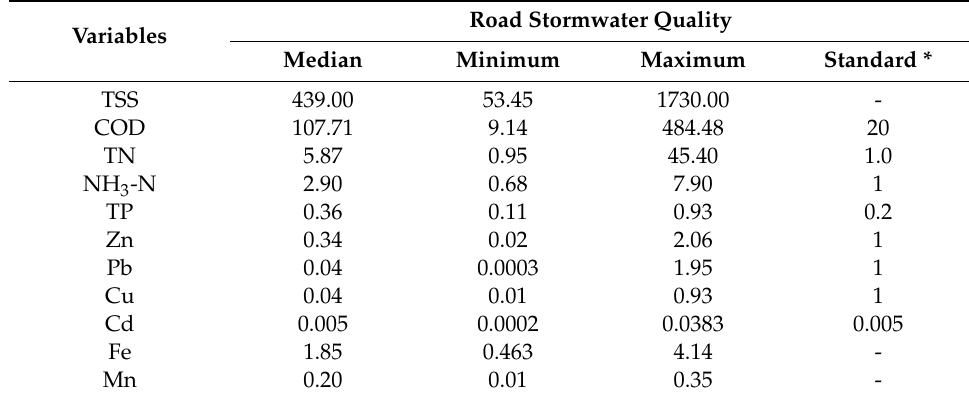
Table 6. Summary of the physicochemical characteristic of road stormwater quality (mg L − 1 ). Road Stormwater Quality Variables Median Minimum Maximum Standard * TSS